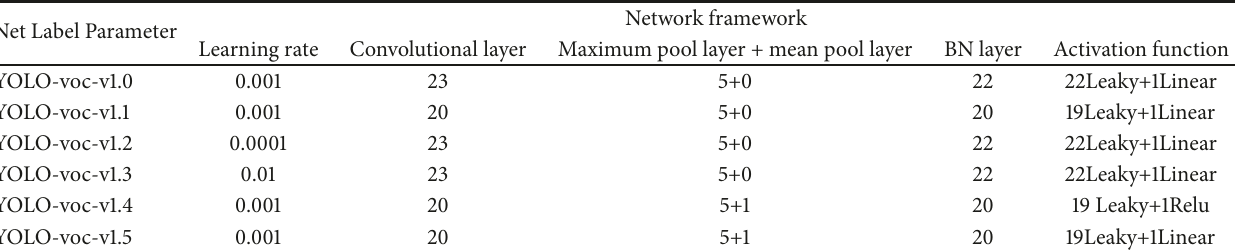
Figure 6: YOLO-vocRV network structure diagram. Table 1: Network